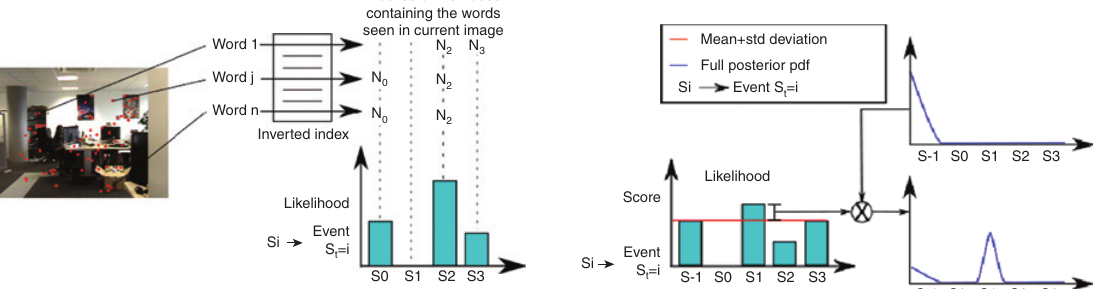
Figure 4. Left: Fast Likelihood Computation By Using Bags of Visual Words and an Inverted Index. Right: Computation of the A Posteriori Probability Based on the Likelihood and the A Priori